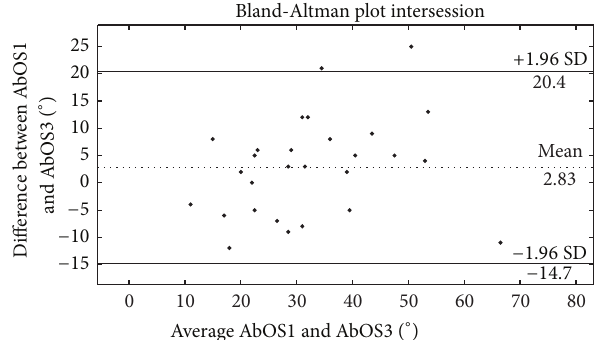
Figure 5: Bland-Altman plots showing the intersession test-retest reliability of the angle between PO and SP (AbOS). The difference between two consecutive AbOSs is plotted against the mean of the same AbOSs. The central dotted line shows the mean of the differences. The two lines above and below the mean represent the 95% upper and lower limits (two standard deviations).